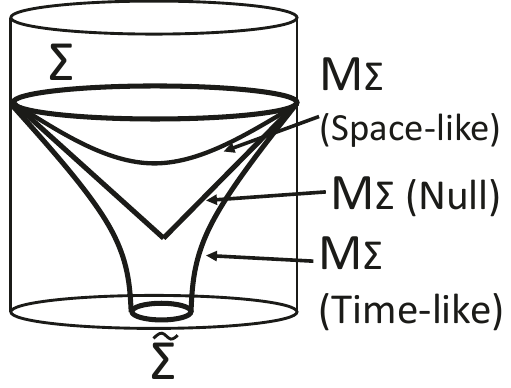
Figure 3 . The path-integral construction of the state j (cid:9) (cid:6) i when we take (cid:6) in Lorentzian AdS. M (cid:6) can be either time-like, null or